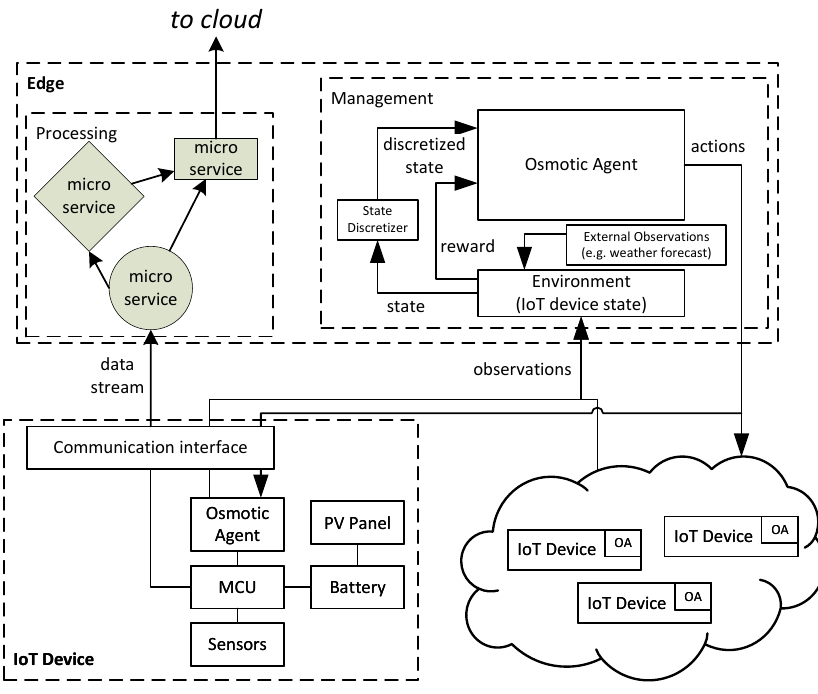
Figure 2. System